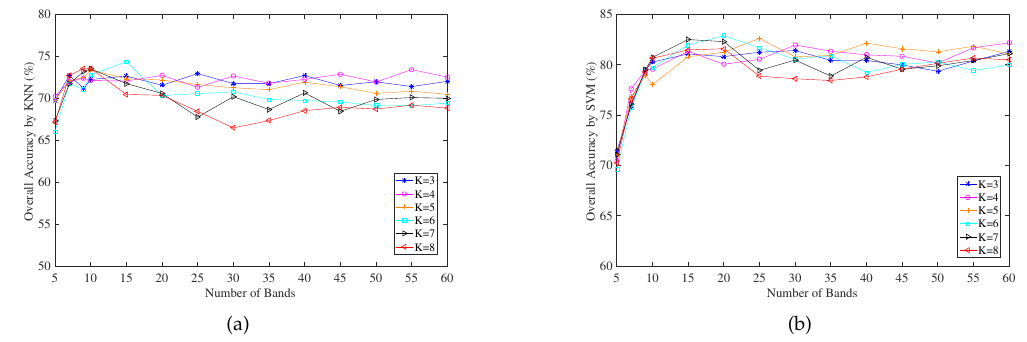
Figure 2. OA for parameters K by selecting different number of bands on Indian Pines data set. ( a ) and ( b ) OA by KNN and SVM classifiers, respectively.